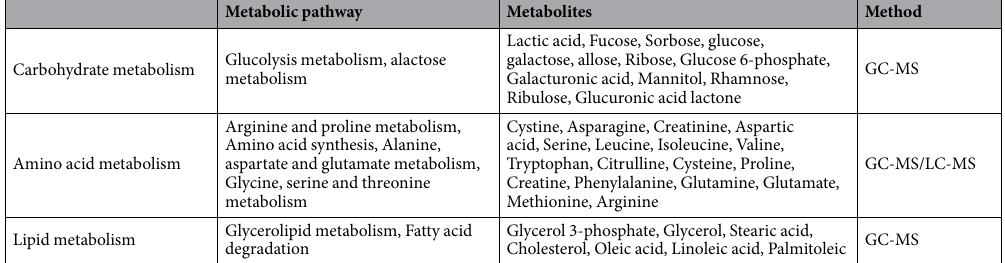
Table 2. Metabolites and metabolic pathways related to lactation performance of sows.